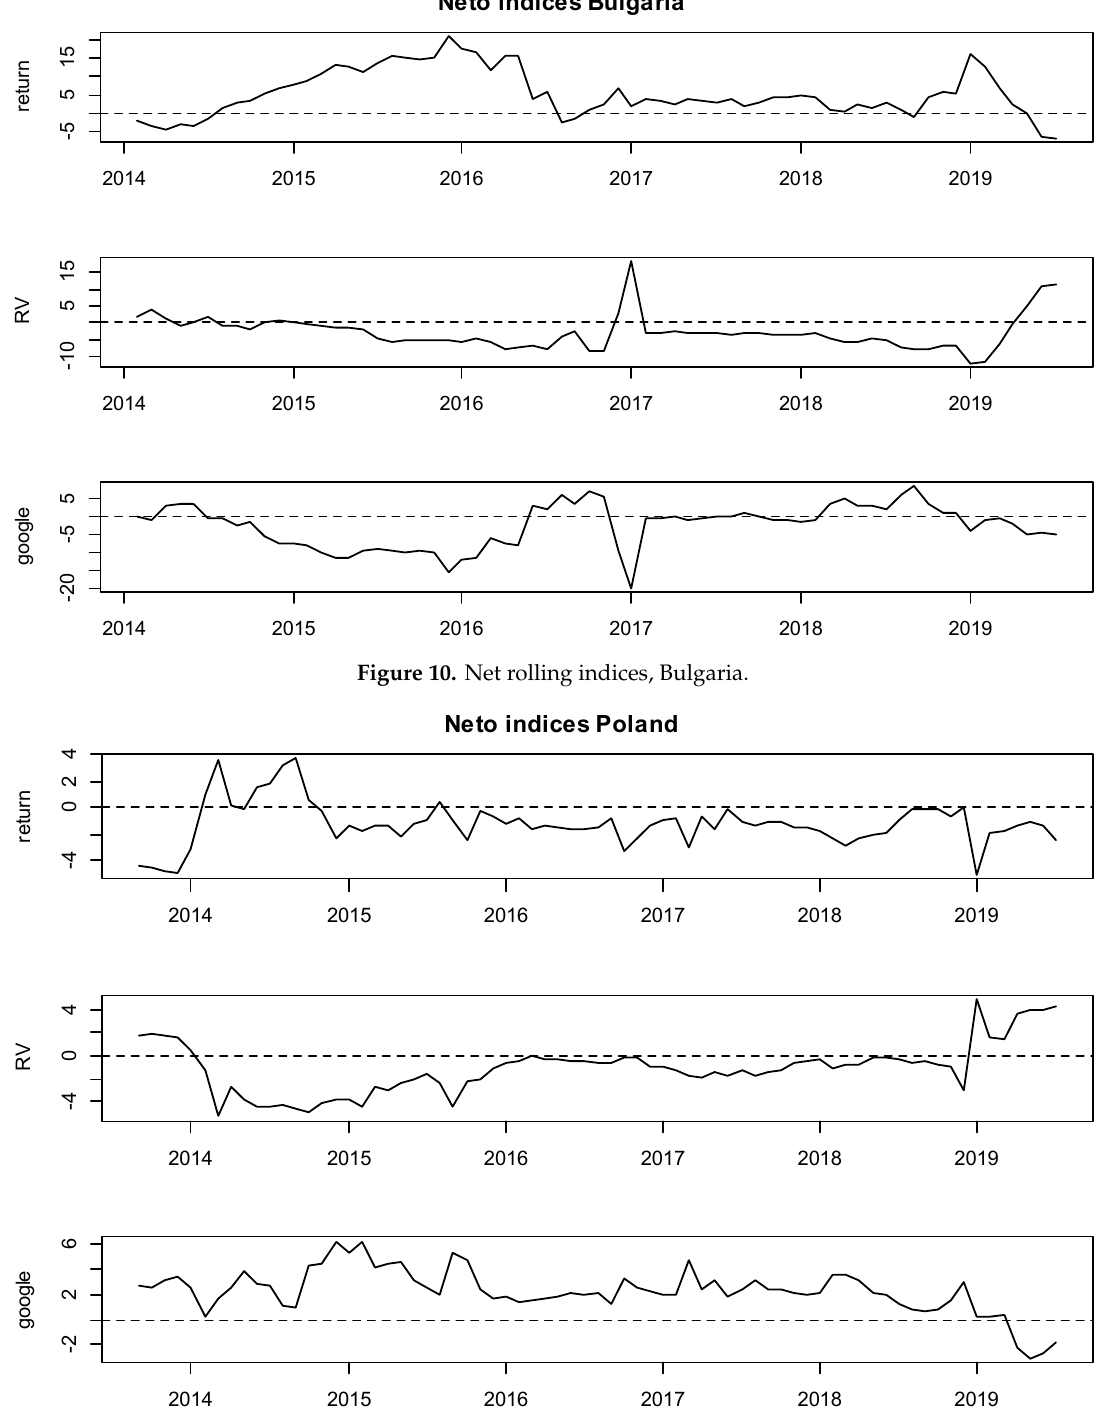
Figure 11. Net rolling indices, Poland.